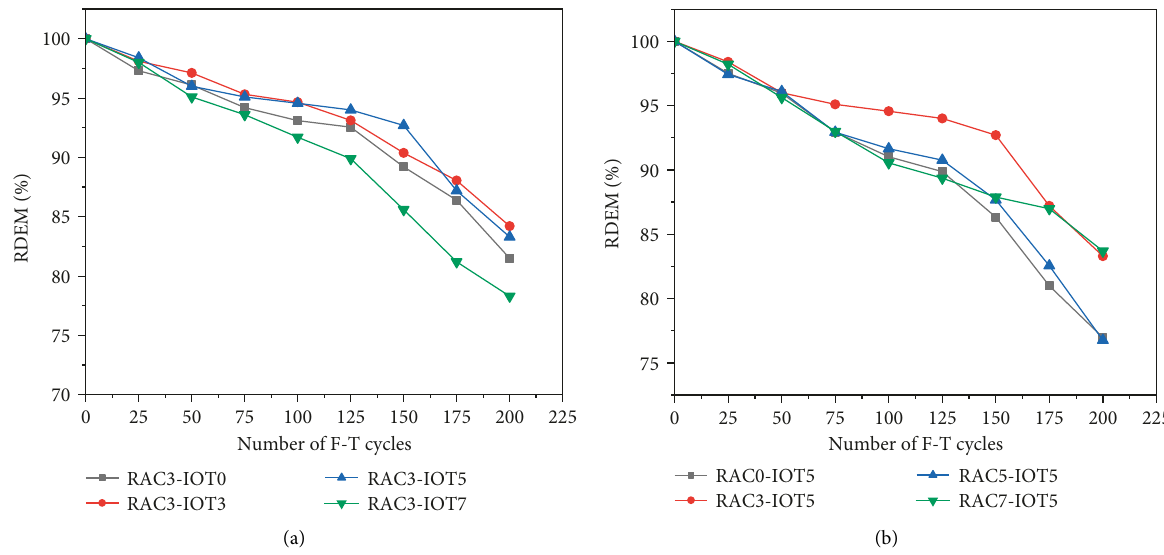
Figure 10: Change rate of RDEM of iron ore tailings recycled aggregate concrete during F-Tcycle: (a) the replacement rate of RCA is 30%; (b) the replacement rate of IOT is 50%.